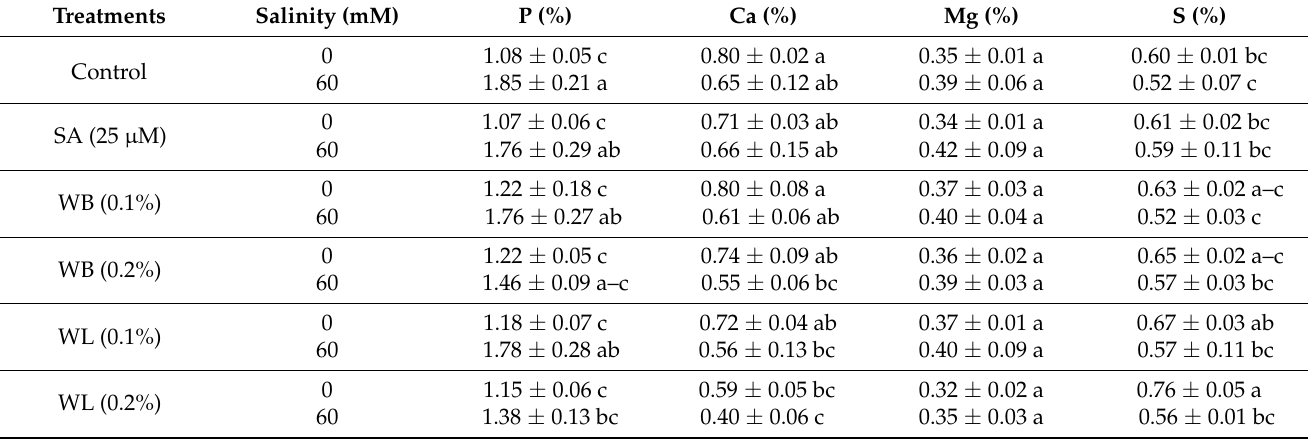
Table 5. Changes in shoot macronutrient (P, Ca, Mg, S) concentrations of 30 DAS hydroponically grown maize ( Zea mays cv. Caramelo) plants in response to salinity (non-salinity stress, 0 mM; salinity stress, 60 mM) and biostimulant applications (SA, salicylic acid (25 µ M); WB, willow bark extract (0.1% or 0.2% w/v ); WL, willow leaf extract (0.1% or 0.2% w/v